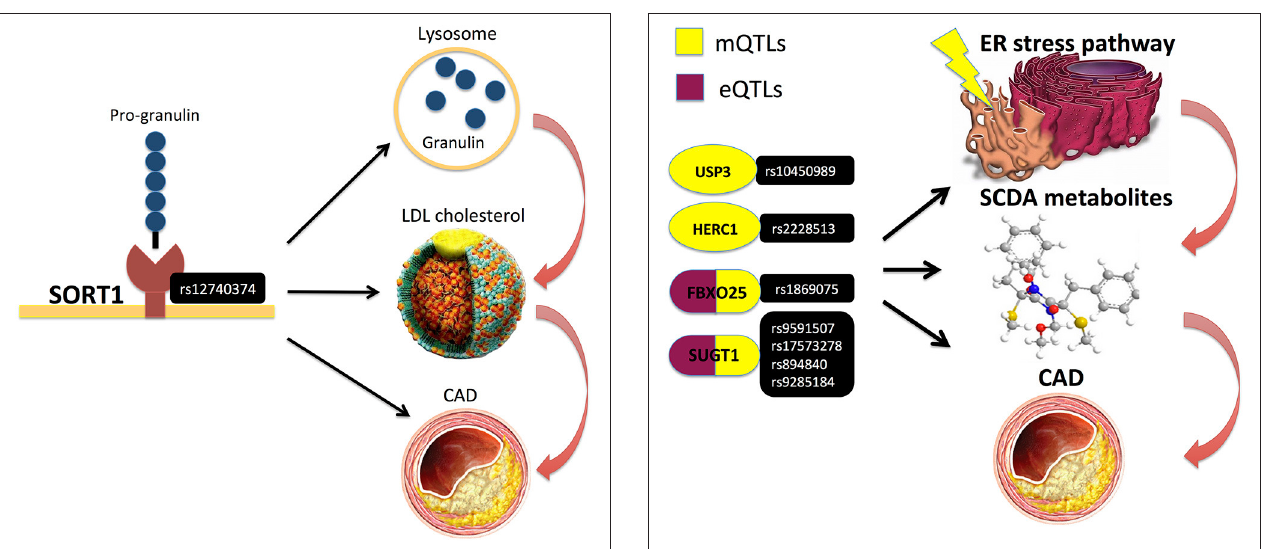
FIGURE 7 | rs12740374 at the CELSR2/SORT1 locus, (40) a variant associated with lipids and CAD, was recently found to display pQTL effects on plasma granulin levels, and pro-granulin is known to bind to SORT1. More recently, it was also demonstrated that progranulin is involved in lysosomal homeostasis and lipid metabolism (74).